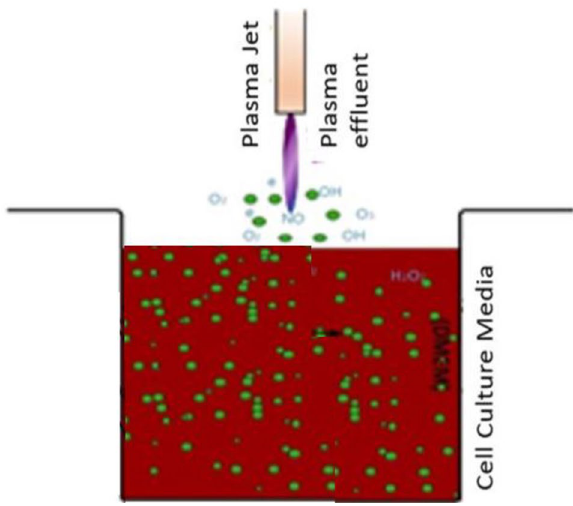
Figure 6. The schematic of plasma-treated cells in cell-suspension.